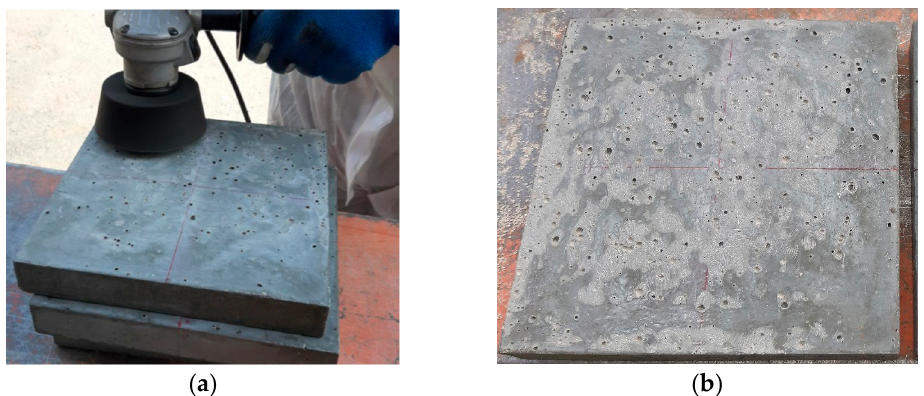
Figure 7. Casting of UHPFRC plates with moulds in ( a ) horizontal position; ( b ) vertical position.